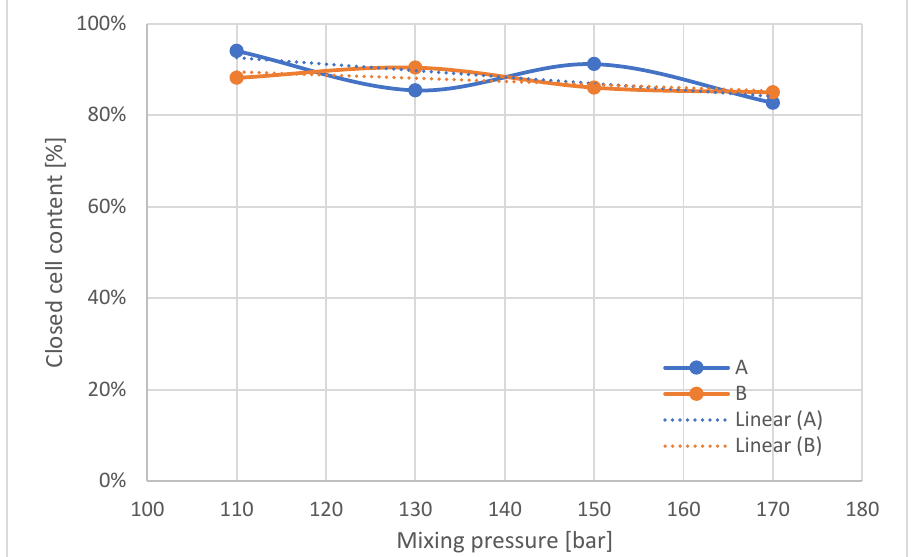
Figure 8. Bubble merging tendency.